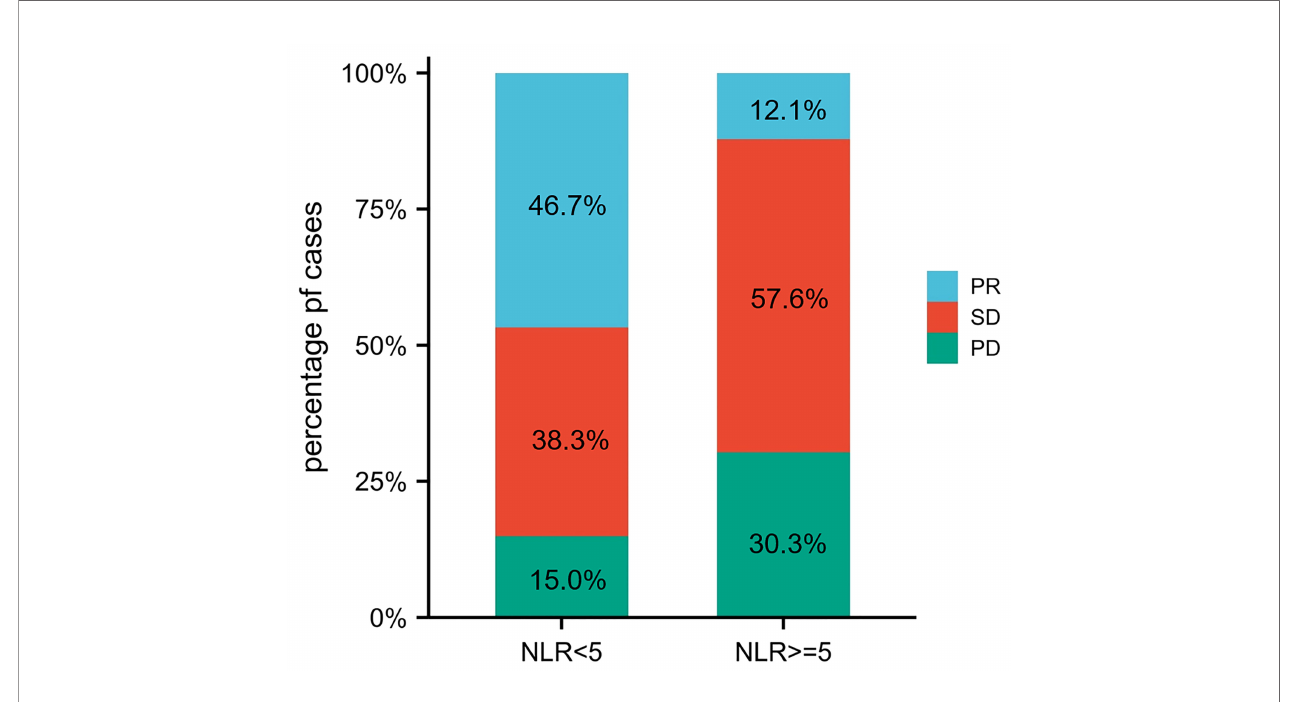
FIGURE 3 | The distribution of treatment ef fi cacy between two groups.